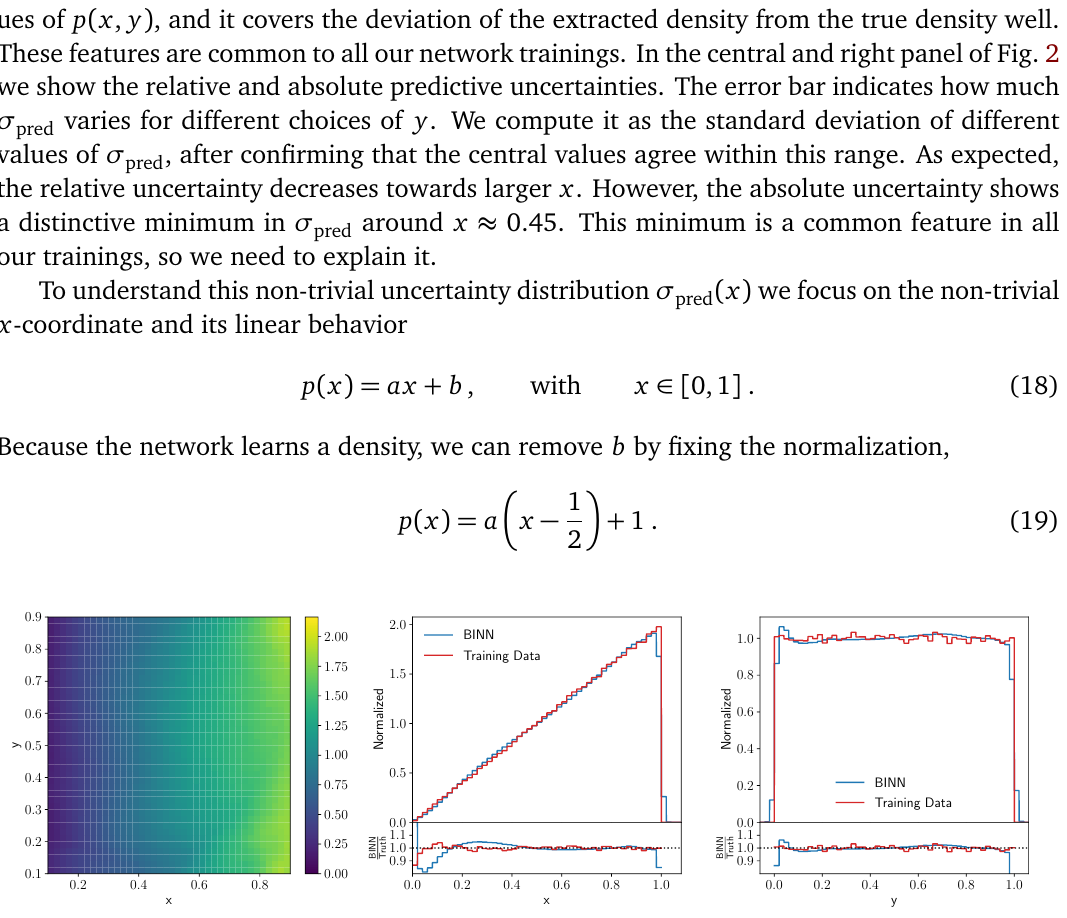
Figure 1: Two-dimensional and marginal densities for the linear wedge